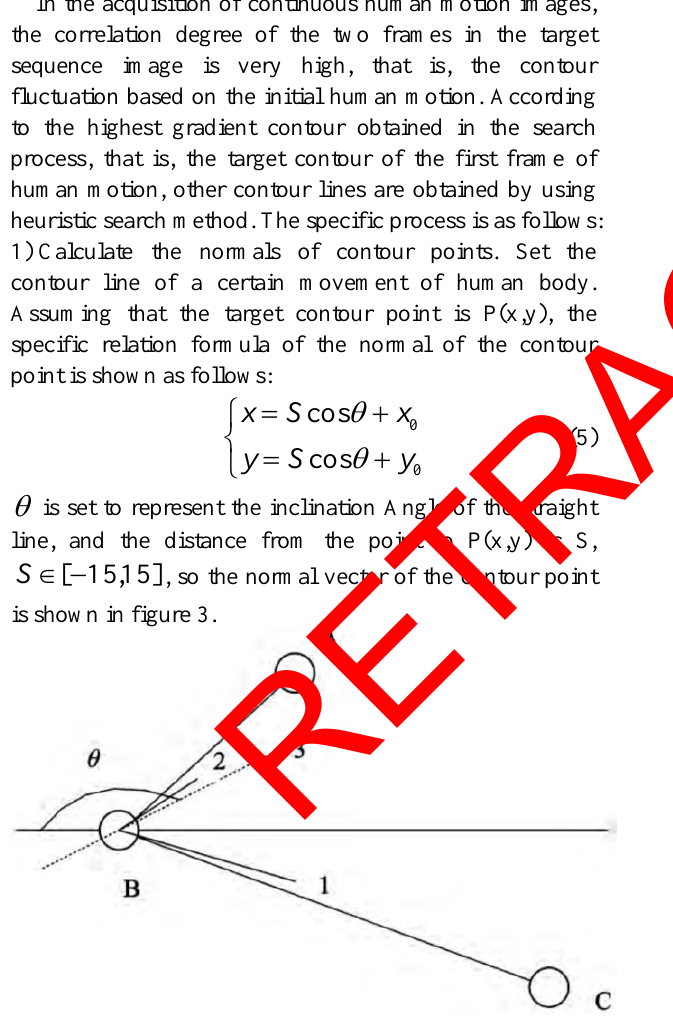
Figure 3. The normal vector of the contour point